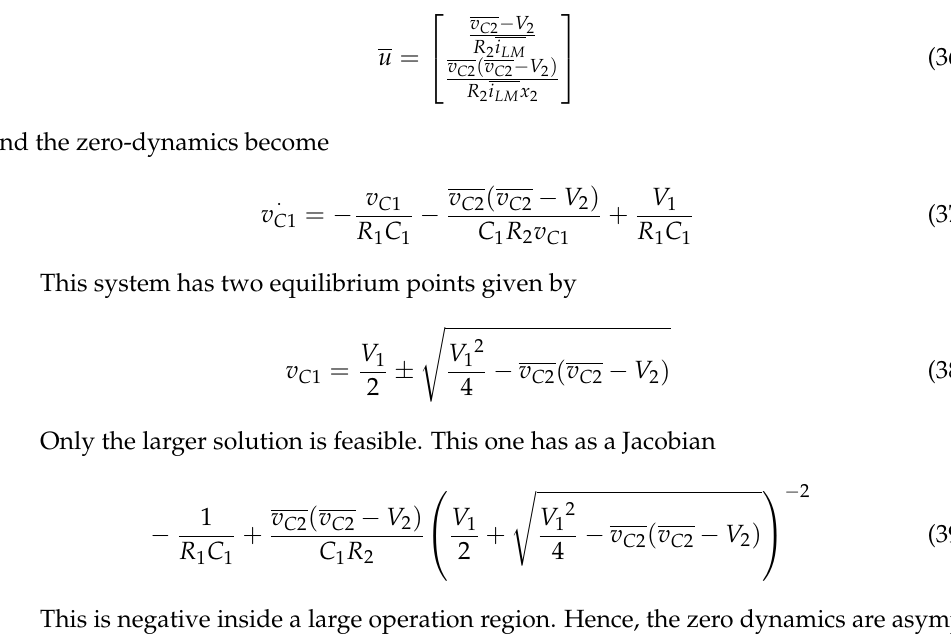
Figure 9. Model of the DIDO system with the state feedback linearization network and simple P-type controllers.